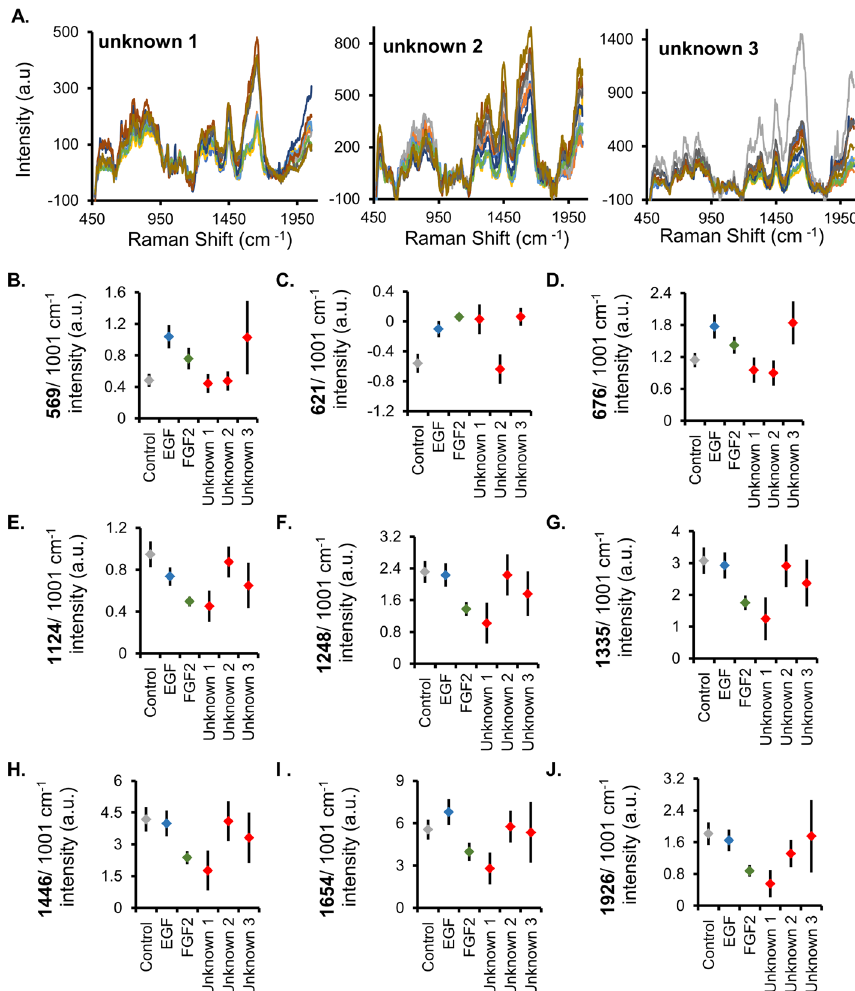
Fig. 5 Unknown organoids identified using analysis of select Raman spectral peaks. A Raman spectra of cell-dense organoid region for each unknown (blinded) organoid dataset (ten processed, normalized spectra per treatment). B – J Comparison of the mean Raman peaks between the known samples (full spectra in Fig. 3) and the unknown datasets. Error bars equal 95% confidence interval. Table 2 details the assignment of the unknown peaks to specific